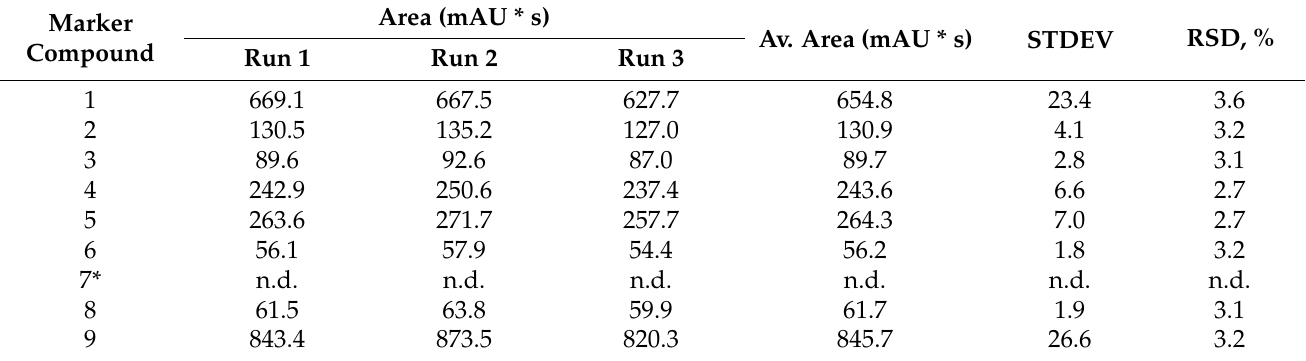
Table 2. Triplicate analysis of GS1 using the optimized HPLC analysis